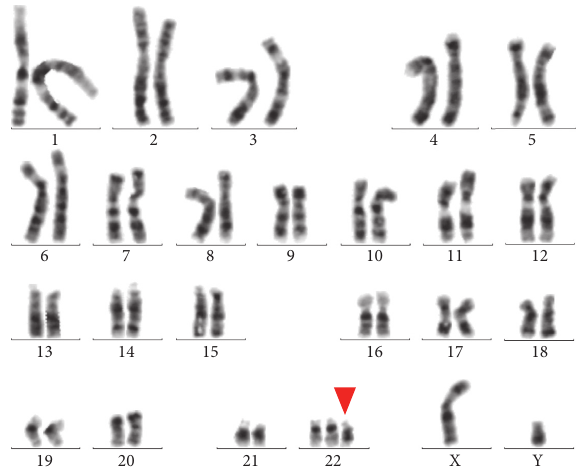
Figure 2: G-banding metaphase and karyotype of